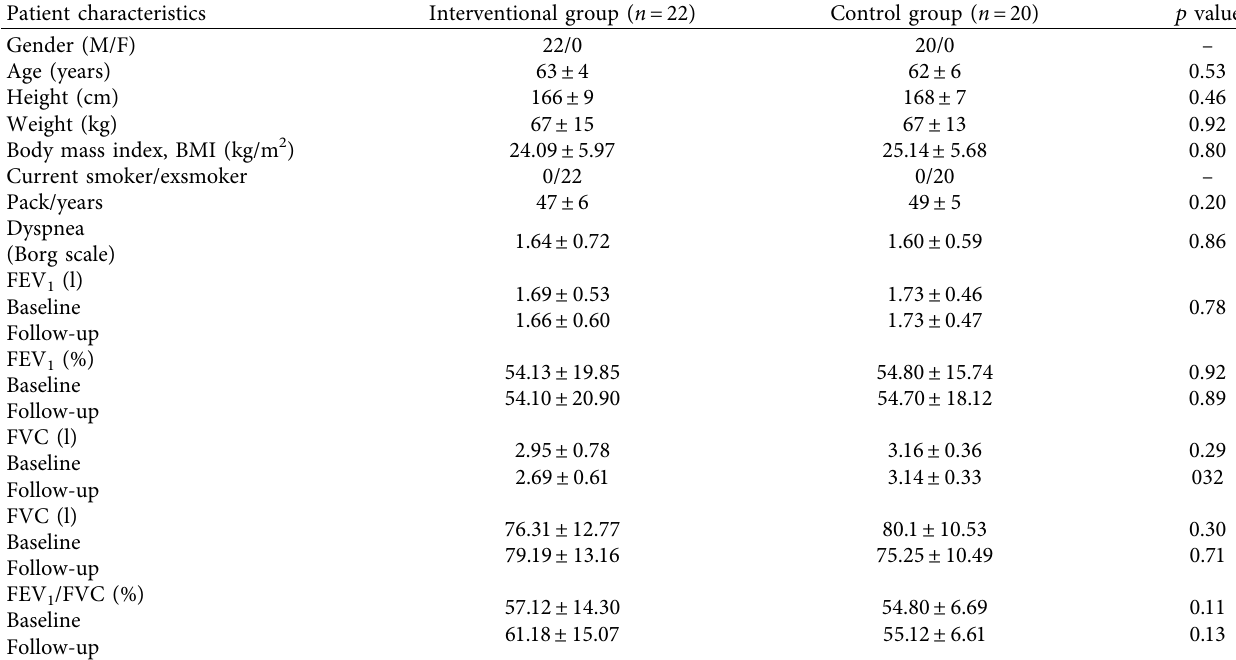
Table 1: Anthropometric characteristics and pulmonary function before and after the intervention.